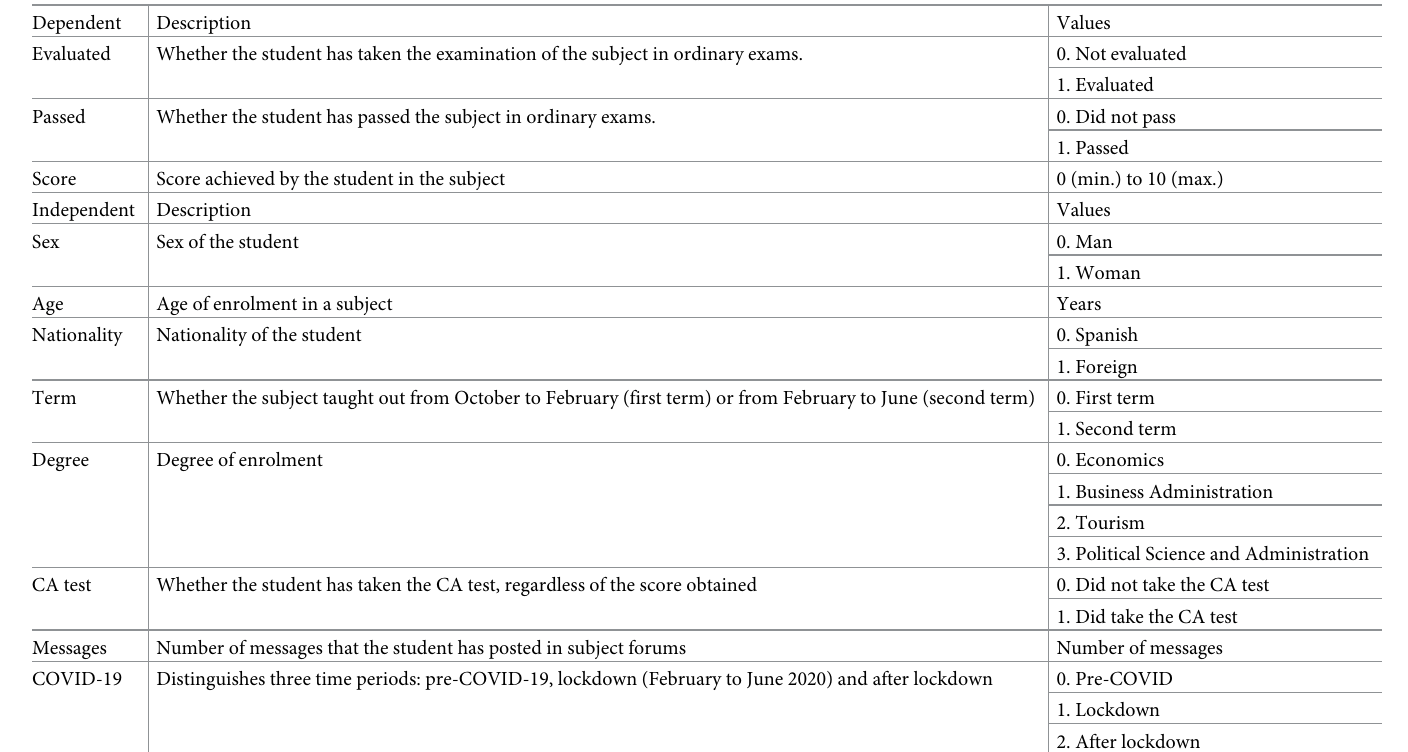
Table 3. Description and measurement of the